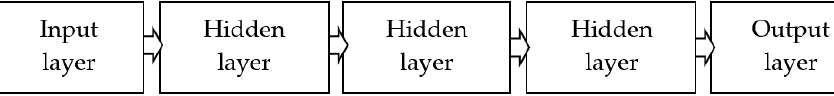
Figure 9. DNN model.